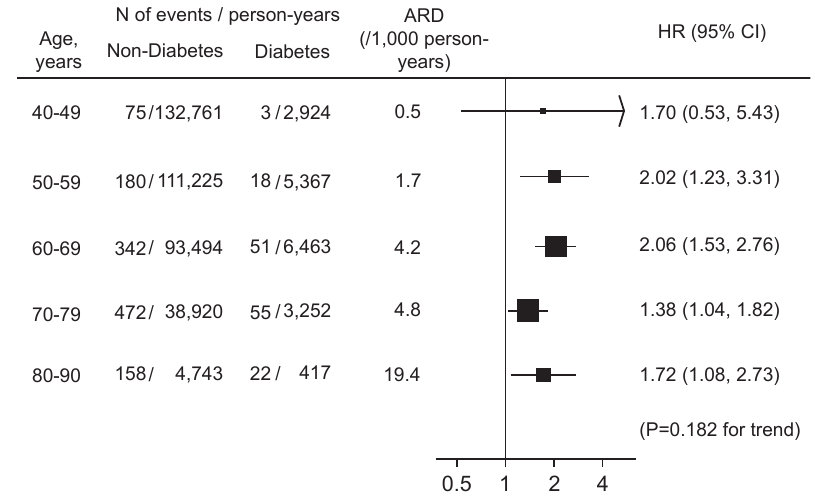
Fig.1. Relative and absolute risk of death from cardiovascular disease associated with diabetes in each age group. The HRs and 95% CIs were calculated among age groups using the sex-adjusted strati fi ed Cox model. The trend in the in fl uence of diabetes on cardiovascular risk across age categories was tested byadding a multiplicative interaction term between diabetic status and ordinal age groups to the relevant Cox model. ARD, absolute risk difference; CI, con fi dence interval; HR, hazard